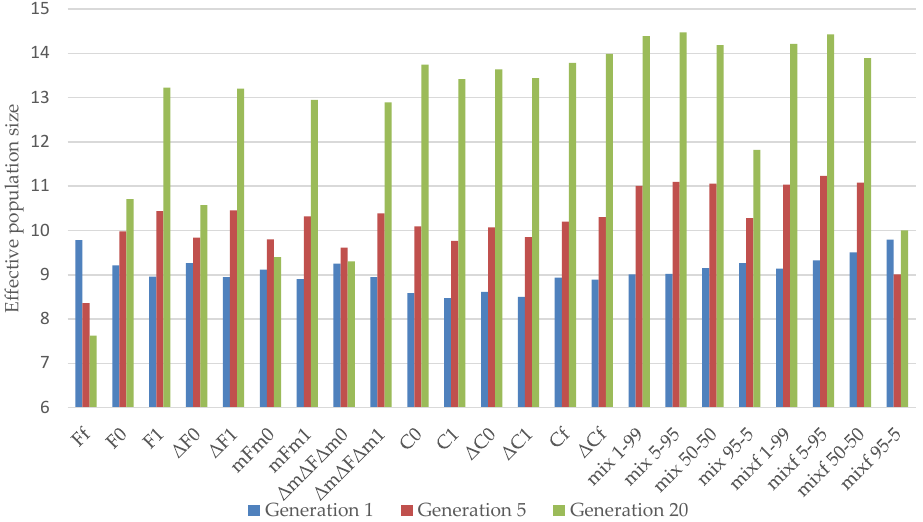
Figure 3. Effective population size obtained by the different strategies in the reference population of La Lajita in 1, 5, and 20 generations. (Ff, F0, and F1) based on minimum coancestry of the parents; ( ∆ F0 and ∆ F1) based on increment in coancestry of the parents; (mFm0 and mFm1) based on weighted coancestry; ( ∆ m ∆ F ∆ m0 and ∆ m ∆ F ∆ m1) based on weighted increase in coancestry; (C0, C1, and Cf) based on coancestry of the offspring; ( ∆ C0, ∆ C1, and ∆ Cf) based on increase in coancestry of the offspring; (mix 1–99, mix 5–95, mix 50–50, mix 95–5, mixf 1–99, mixf 5–95, mixf 50–50, and mixf 95–5) mixing information from the parents’ coancestry and offspring’s